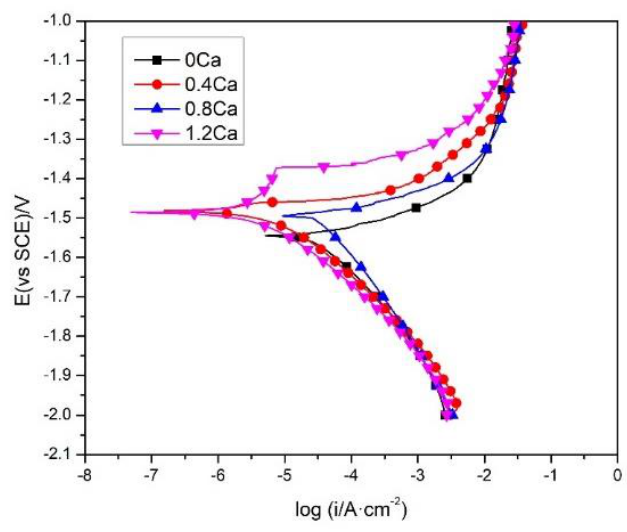
Figure7. PotentiodynamicpolarizationcurvesoftheextrudedMg–7Li–3Al–xCaalloys. Themeasurements were performed in a 3.5 wt.% NaCl solution. Figure 7. Potentiodynamic polarization curves of the extruded Mg–7Li–3Al–xCa alloys. The measurements were performed in a 3.5 wt.% NaCl solution.